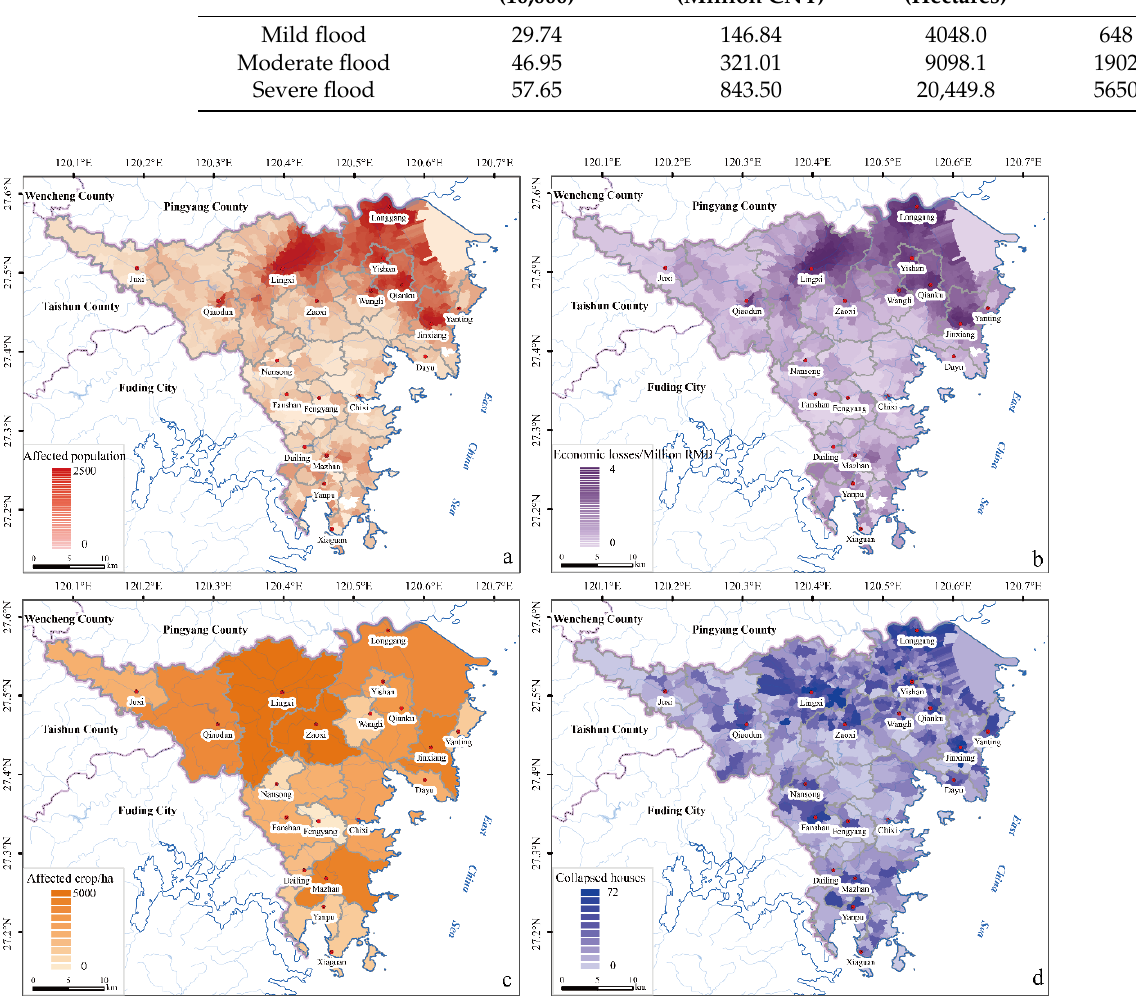
Figure 8. Spatial patterns of severe flood risk in Cangnan County: ( a ) population, ( b ) economy, ( c ) crops, and ( d )